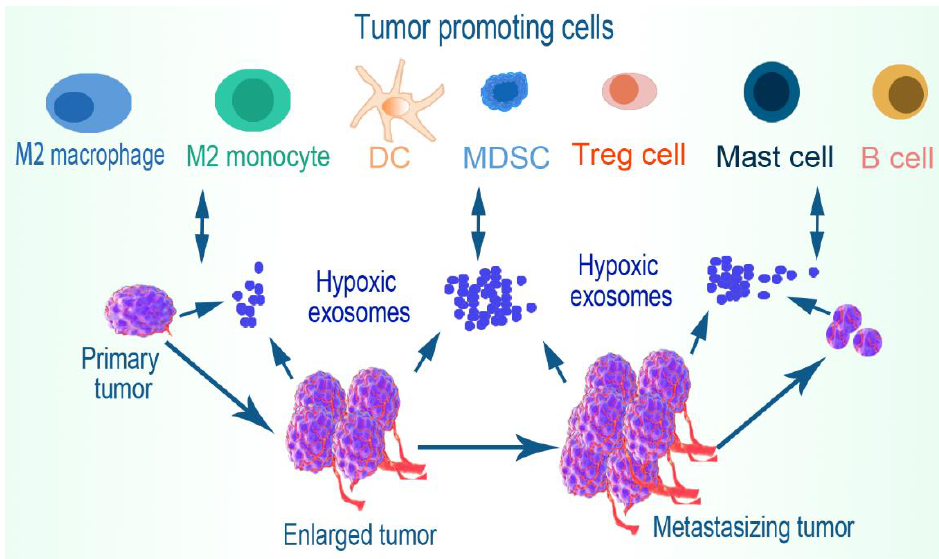
Figure 3. Tumor cell immune evasion. Within the TME, hypoxic exosomes induce the immune cells to become tumor friendly. Both the increased polarization of immune cells toward anti-inflamma- tory phenotypes and the deactivation/dysfunction of antitumor immune cells drive the tumor-pro- moting environment. The resultant microenvironment enhances tumor-friendly immune cell cyto- kine expression, together with other regulatory exosomal cargos that facilitate tumor cell immune evasion and result in tumor growth and